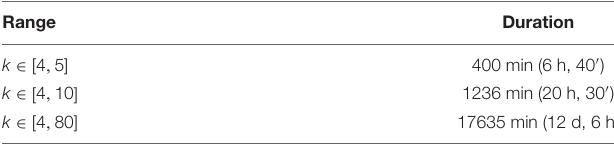
TABLE 2 | Execution times of the proposed algorithm.